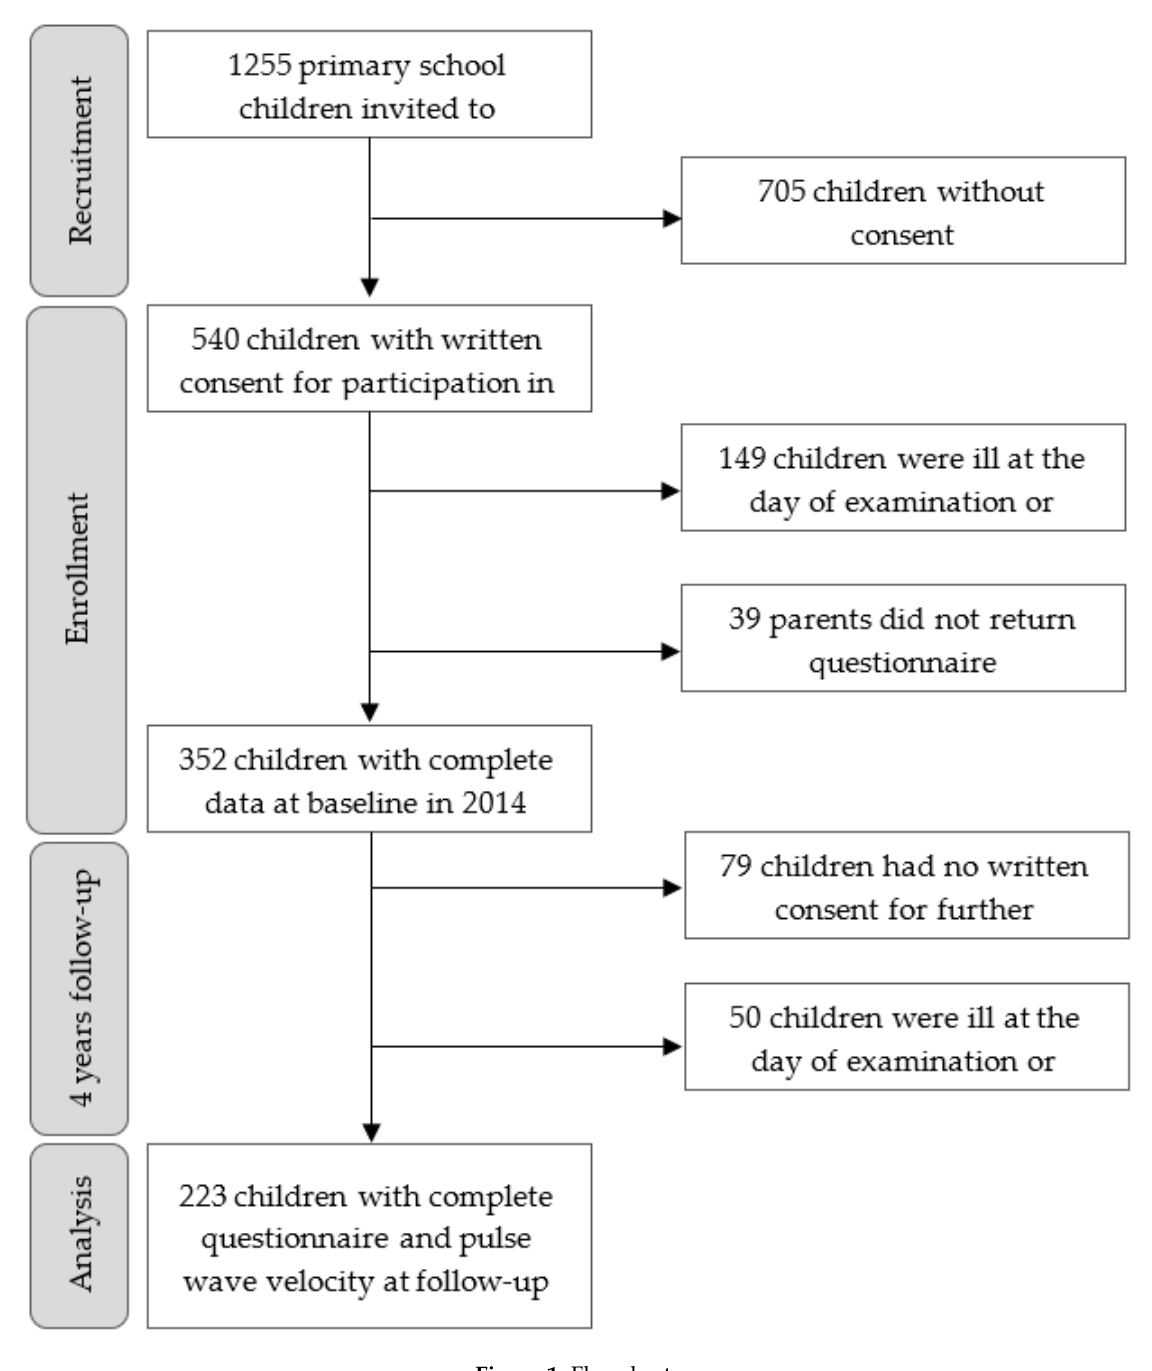
Figure 1. Flowchart. Table 1. Population characteristics.